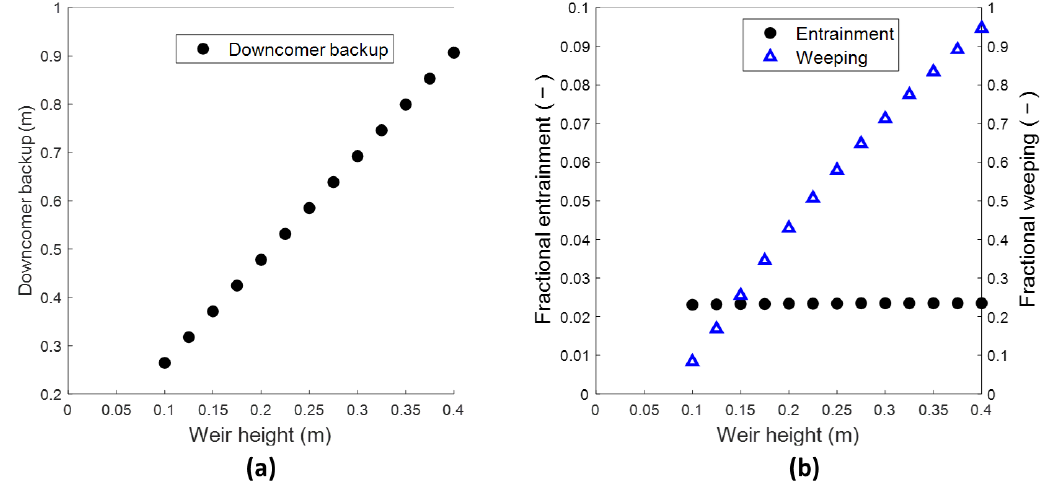
Figure 5. Limiting hydraulic phenomena using sieve trays for Luyben’s column at varying weir heights; downcomer backup ( a ), fractional entrainment and weeping ( b ). Values reported are the highest encountered in the reactive section. TS = 600 mm, each downcomer area = 10% of column cross section. A G /A n = 0.10 *, d t = 3.4 mm *, d h = 13 mm *. * Based on normal values for conventional